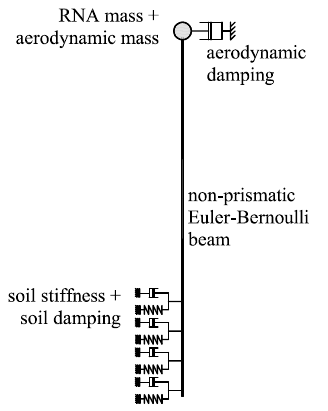
Figure 4. Example of a decoupled model of a monopile-based support structure, with the rotor-nacelle assembly (RNA) replaced by a concentrated